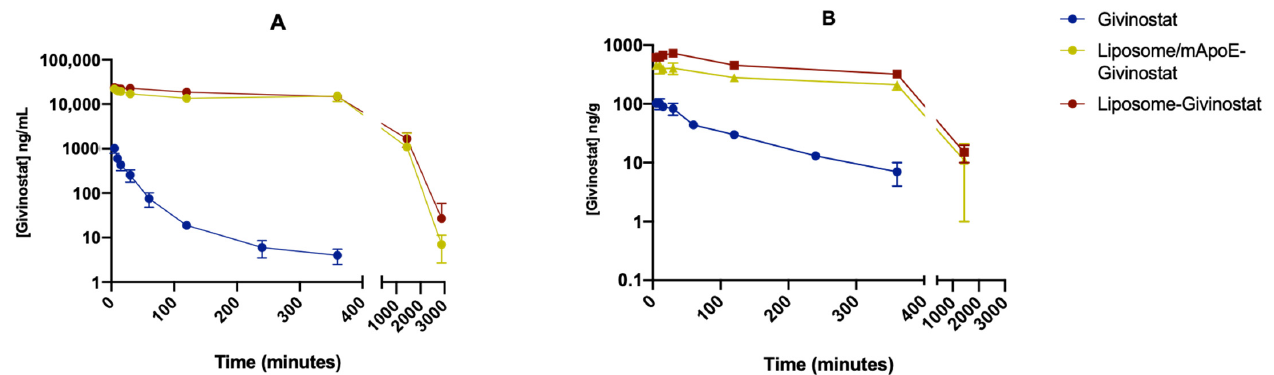
Figure 2. Concentration of Givinostat detected in plasma and brain after i.v. administration of free Givinostat, LIP ‐ GIV, or LIP/m ‐ GIV. ( A ) Plasma concentration of Givinostat from 5 min to 48 h post ‐ injection. ( B ) Brain concentration of Givinostat from 5 min to 48 h post ‐ injection. Data were obtained through the LC ‐ MS/MS method.